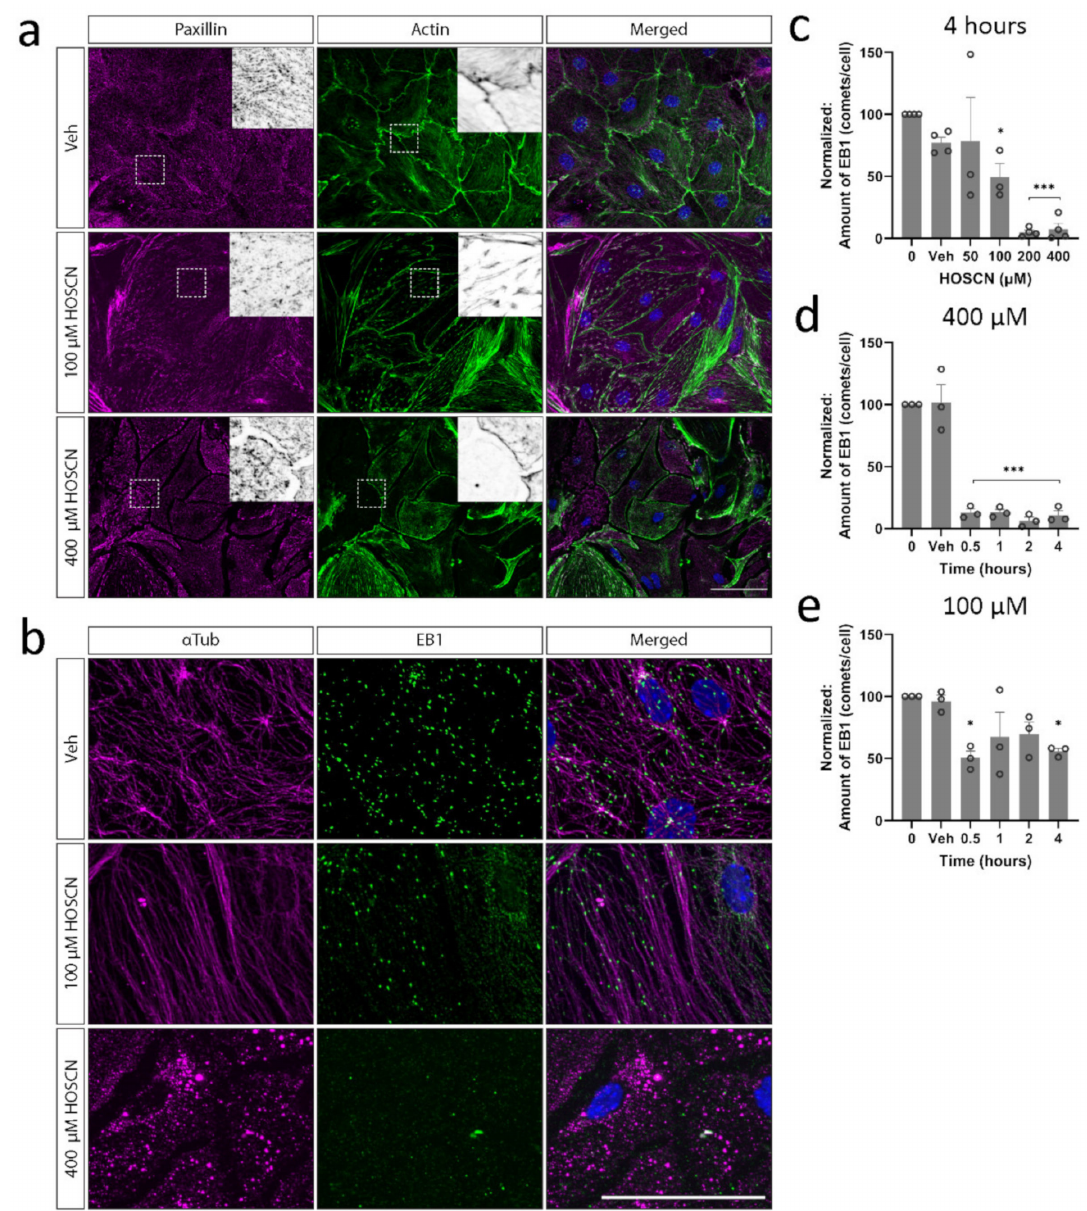
Figure 3. Cytoskeletal structures are disrupted in brain endothelial cells (BECs) treated with hypoth- iocyanous acid (HOSCN). BECs were stained for ( a ) end-binding protein 1 (EB1) to visualise growing microtubules and ( b ) paxillin to visualise focal adhesions on actin structures. Scale ( a ) = 100 µ m, ( b ) = 50 µ m. The number of EB1 comets per cell was quantified, and results are normalised to control conditions. Representative images are shown for vehicle and treatment with 400 µ M HOSCN for 4 h. ( c ) The amount of EB1 is shown for increasing concentrations of HOSCN when treated for 4 h and when treated with ( d ) 400 µ M and ( e ) 100 µ M HOSCN for up to 4 h. Scalebar = 50 µ m. n =